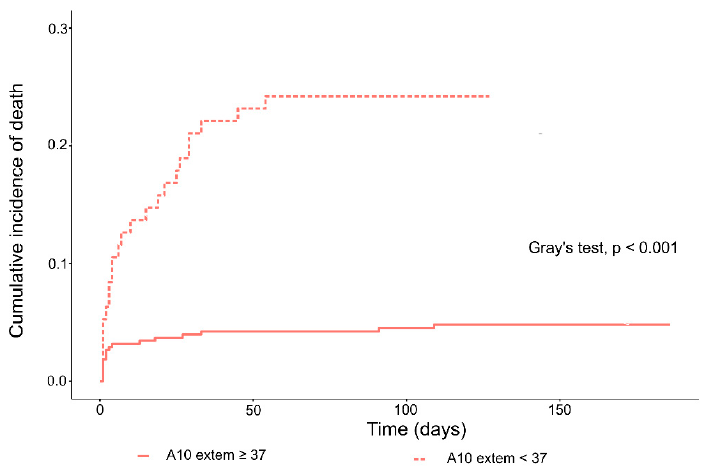
Figure 5. Clot amplitude at 10 min (A10): Plotted cumulative incidence of death.